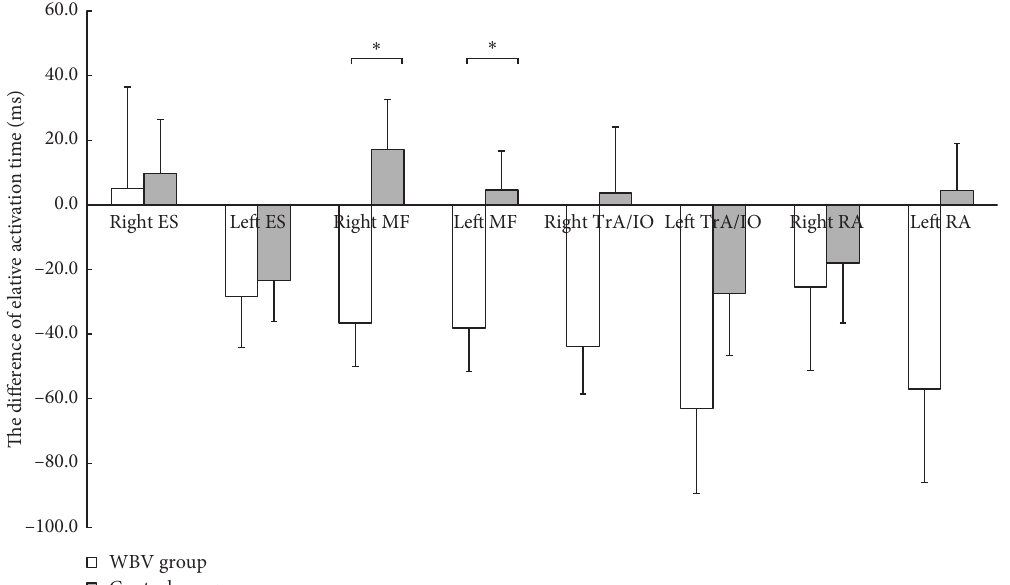
Figure 3: Between-group comparison of variation in relative activation time on shoulder flexion. Variation � post-test–pre-test, a negative value indicated that the intervention shortened the relative activation time, and vice versa. WBV, whole-body vibration; ES, erector spinae; MF, multifidus; TrA/IO, transversus abdominus/internal oblique; RA, rectus abdominis. The independent-samples t -test was used to compare the variation. ∗ Significant at P < 0 .